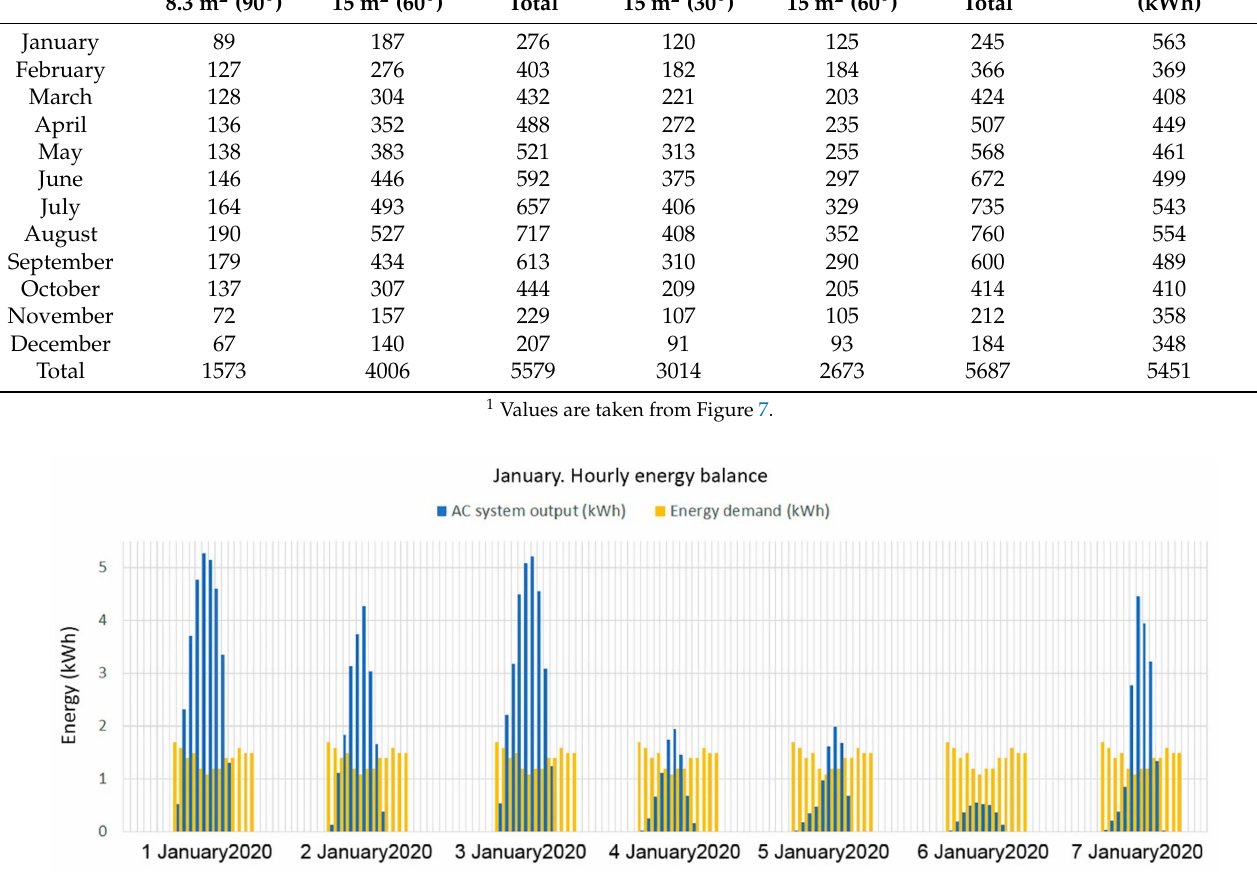
Figure 8. Hourly energy balance. January.